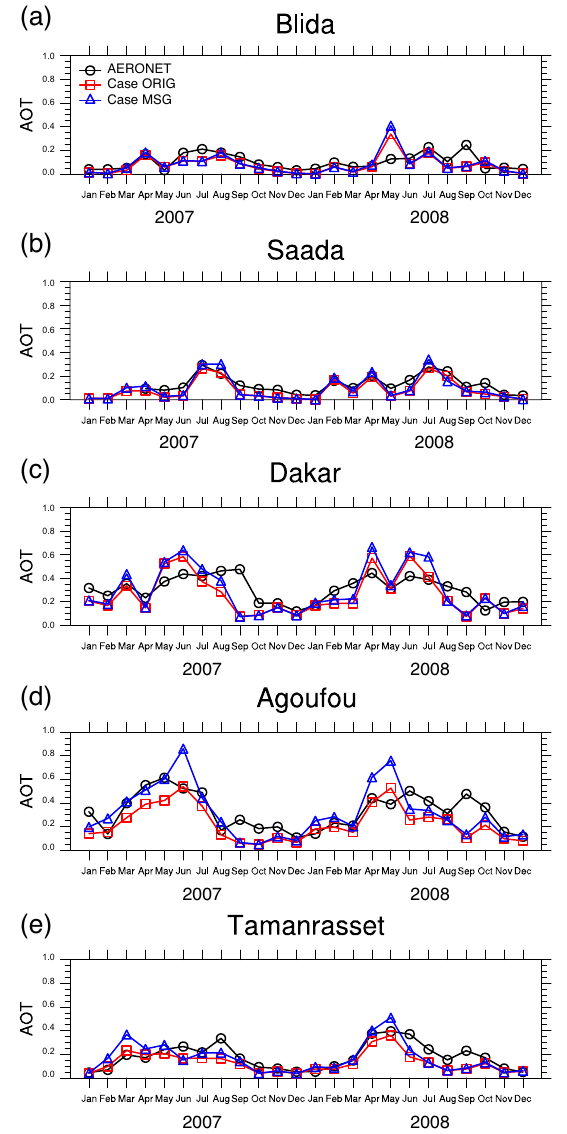
Figure 4. Time series of monthly averages of aerosol optical thick- ness (AOT) at Blida (36.5 ◦ N, 2.9 ◦ E), Saada (31.6 ◦ N, 8.2 ◦ W), Dakar (14.4 ◦ N, 17.0 ◦ W), Agoufou (15.3 ◦ N, 1.5 ◦ W), and Taman- rasset (22.8 ◦ N, 5.5 ◦ E) for the years 2007 and 2008. Compared is the AERONET 500nm coarse-mode data (black line) at quality level 1.5 (2.0 for Blida) and the modeled dust AOT from ECHAM- HAM runs with the MSG-based source mask (blue line) and (red line) with the original map of preferential dust